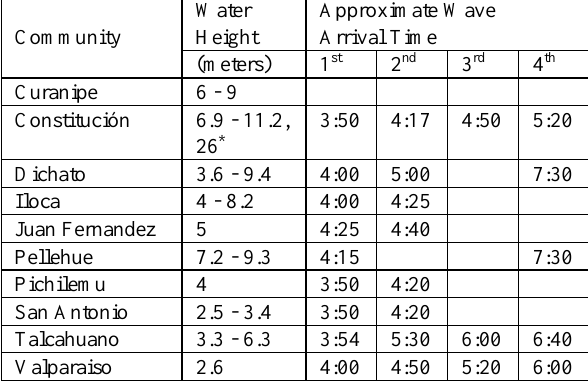
Table 2. Water heights and wave arrival times (NGDC,